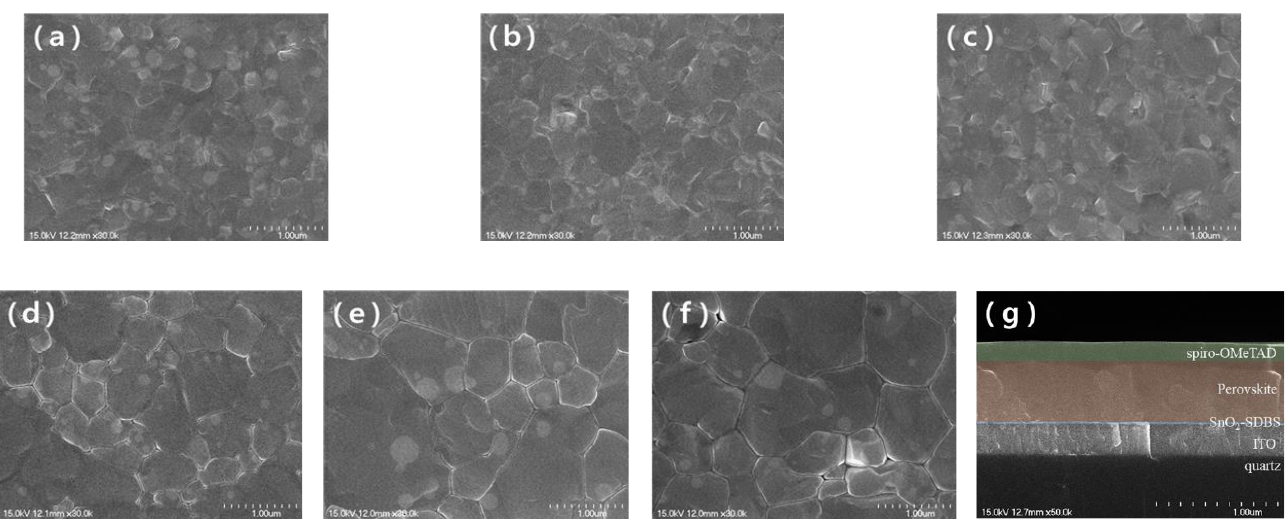
Figure 3. SEM image of the prepared FA x MA 1 − x PbI 3 perovskite film ( a ) FAI-0, ( b ) FAI-5, ( c ) FAI-10, ( d ) FAI-15, ( e ) FAI-20, and ( f ) FAI-25, ( g ) Cross section of an optimized device with individual layers highlighted in different colors.